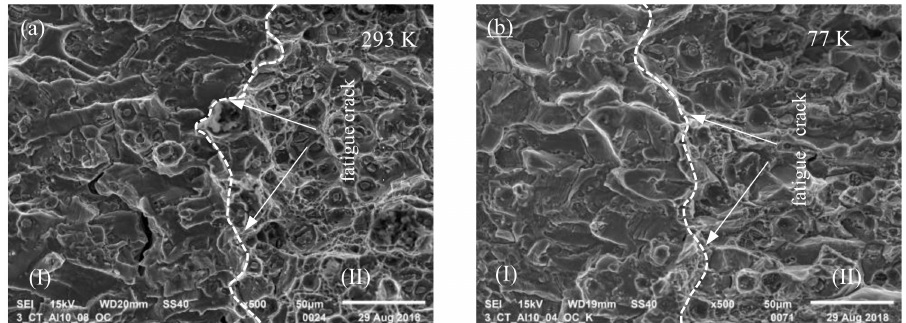
Figure 7. Fatigue crack boundary of compact tension specimens made from AA2519 aluminum alloy ( a ) tested in ambient conditions and ( b ) tested in cryogenic